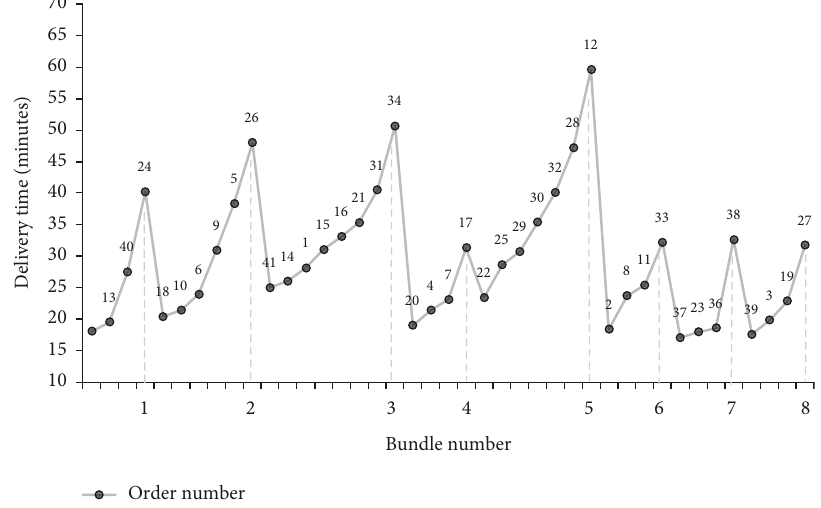
Figure 9: Delivery routes of 8 clustered